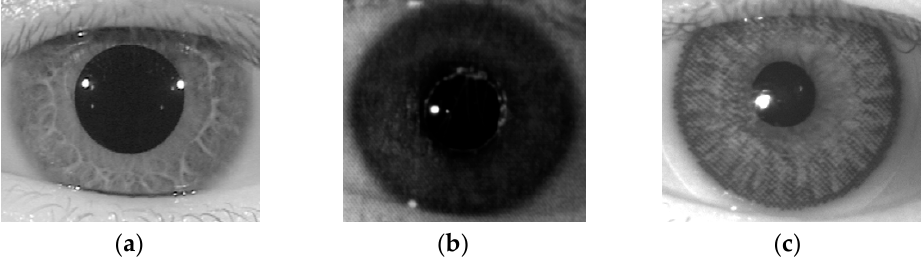
Figure 5. Example of NIR iris images: ( a ) real image; ( b ) presentation attack image obtained by recapturing a printed sample on paper; and ( c ) presentation attack image obtained by recapturing a contact lens.